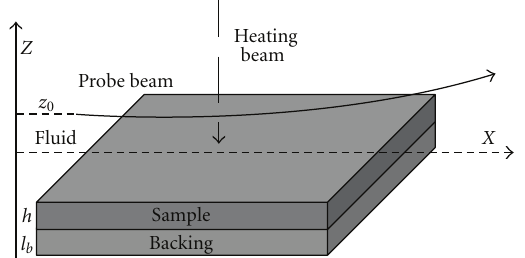
Figure 3: Schema of photothermal deflection principle.